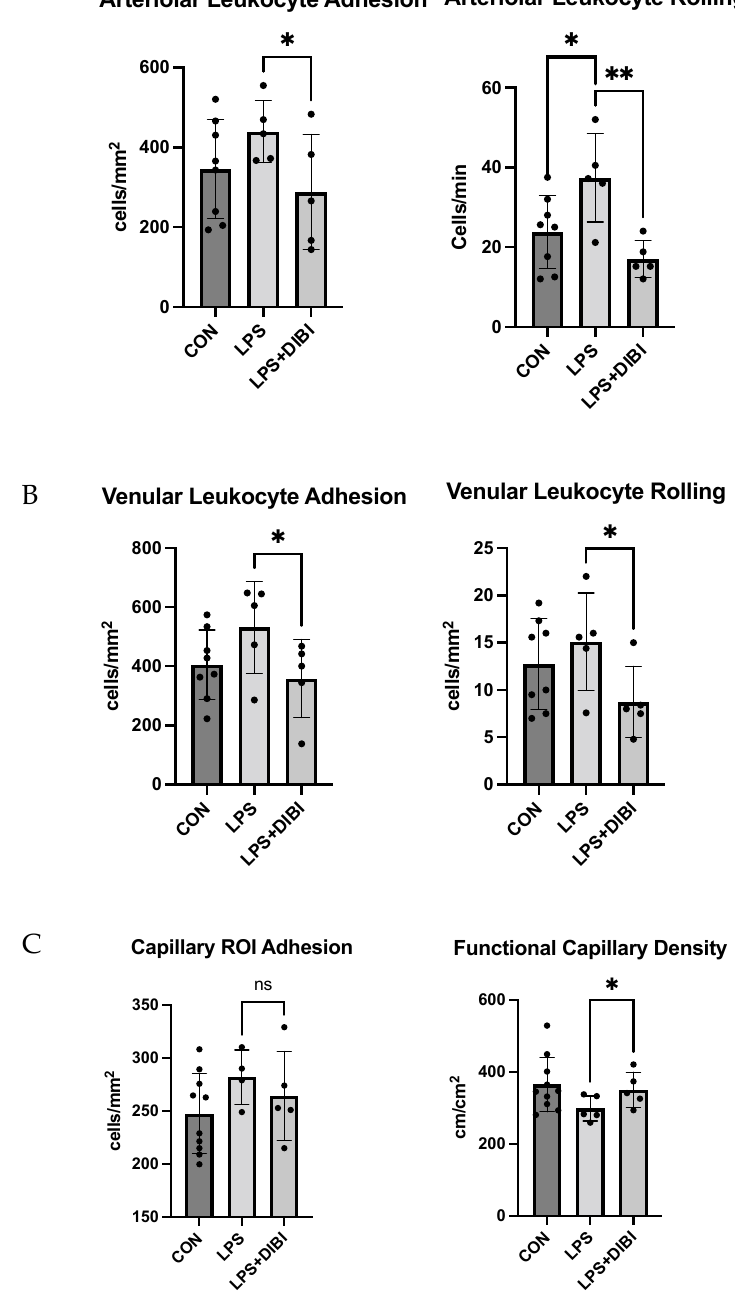
Figure 6. DIBI reduces leukocyte rolling and adhesion and improves capillary perfusion in the pulmonary microcirculation following intranasal LPS challenge in mice. Leukocyte–endothelial interactions (rterioles: A , venules: B , capillaries: C left panel) and functional capillary density ( C right panel) were studied by lung intravital microscopy. Data are expressed as means ± SD for each group ( n = 5–9 mice per group), significant differences are indicated on top of each comparison bars. Groups: CON—control group observed after 6 h; LPS—LPS 5 mg/kg observed after 6 h group; LPS + DIBI—LPS 5 mg/kg and DIBI 80 mg/kg administration at time 0 h observed at 6 h. * p < 0.05, ** p <